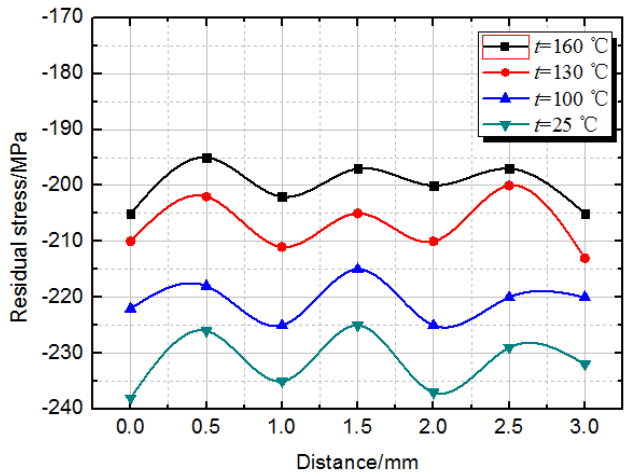
Figure 4. Surface residual stress distribution at different temperatures ( P = 1.8 J).